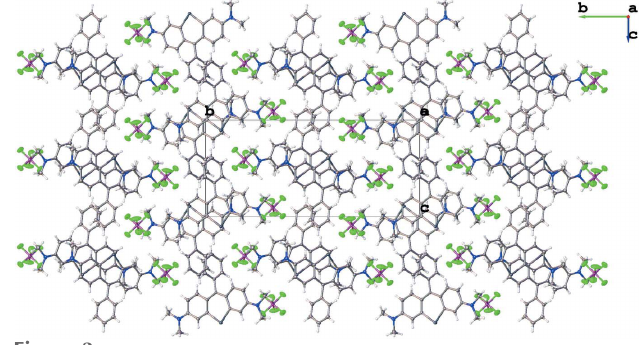
Figure 3 Crystal packing of the title compound viewed along [100].